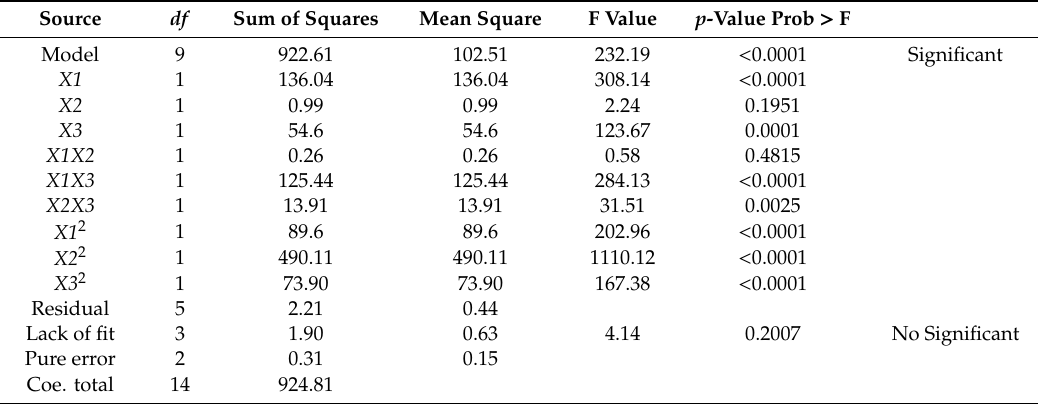
Table 2. Statistical analysis for mathematical model and